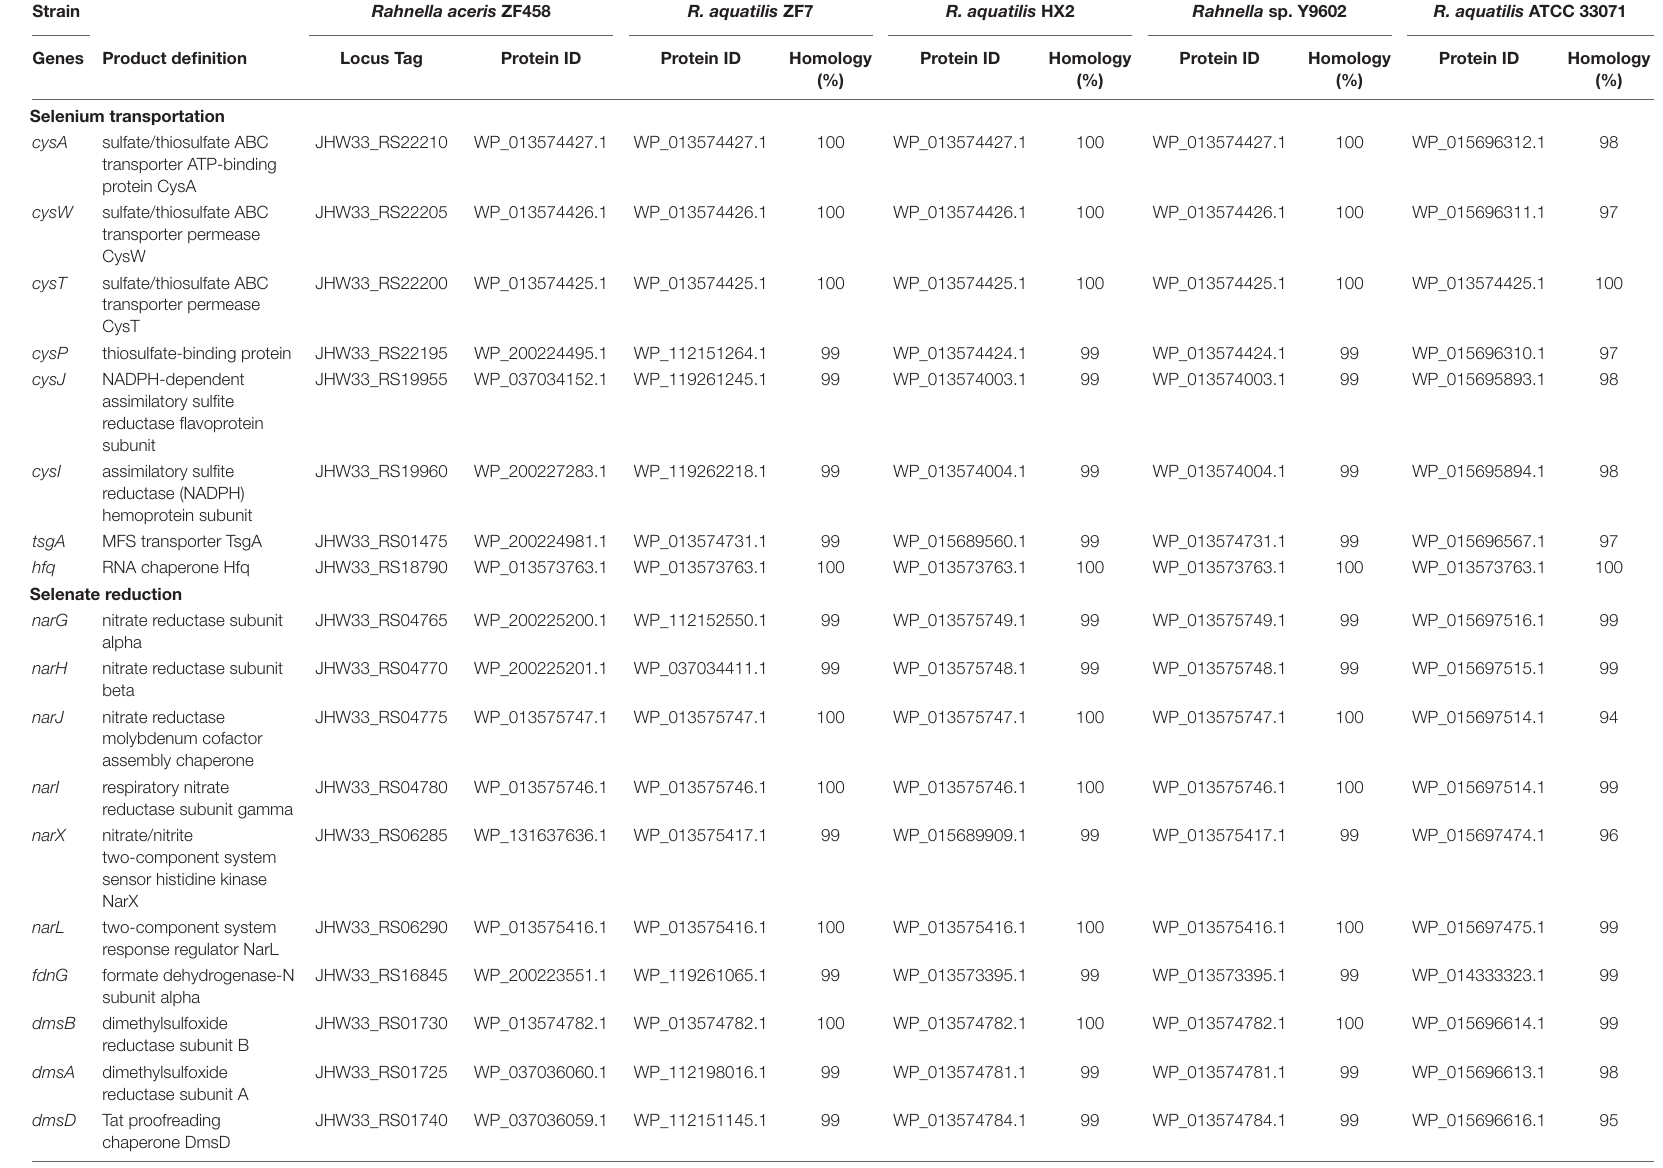
TABLE 5 | Genes related to selenium metabolism in R. aceris ZF458 and other Rahnella